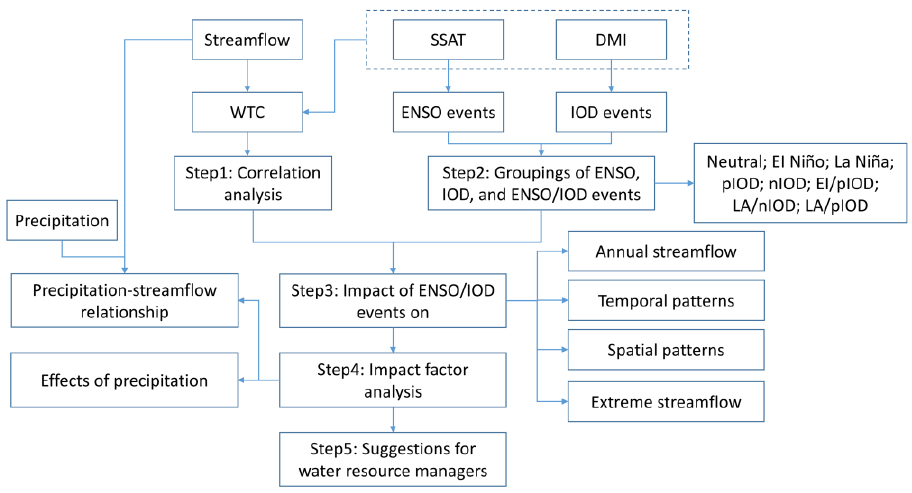
Figure 2. Application of the data.